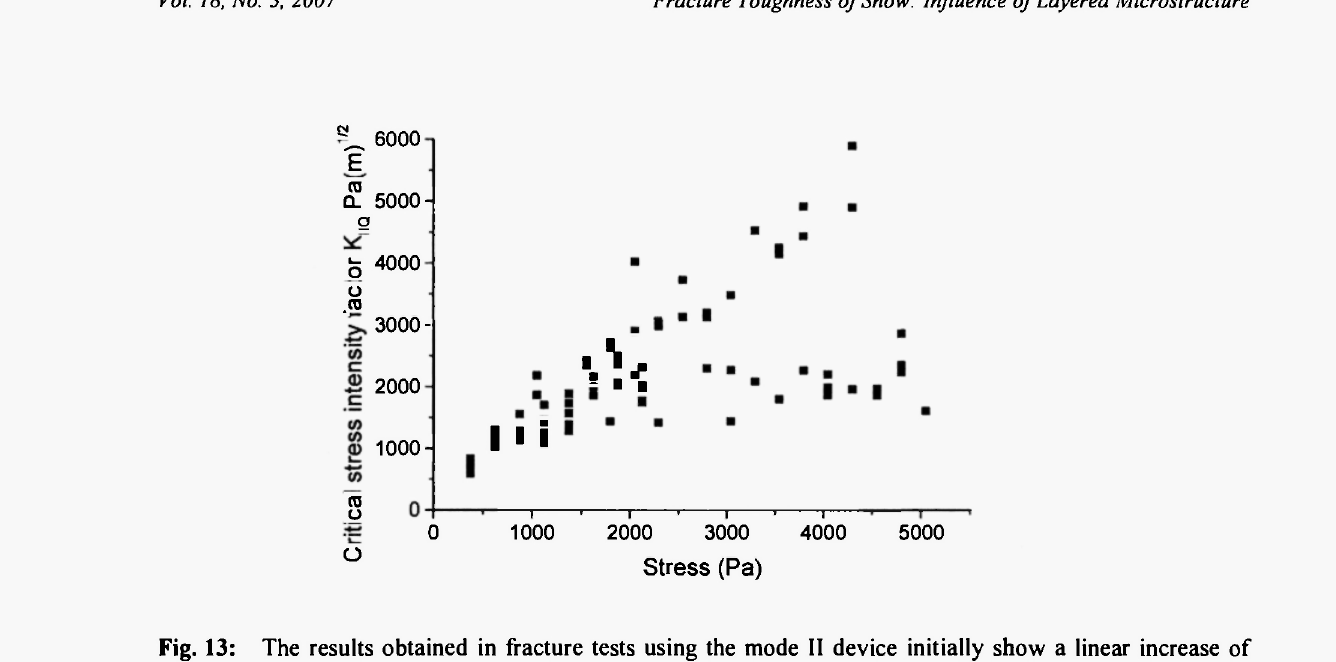
Fig. 13: The results obtained in fracture tests using the mode II device initially show a linear increase of stress intensity with stress. At high stresses the results split into two groups.